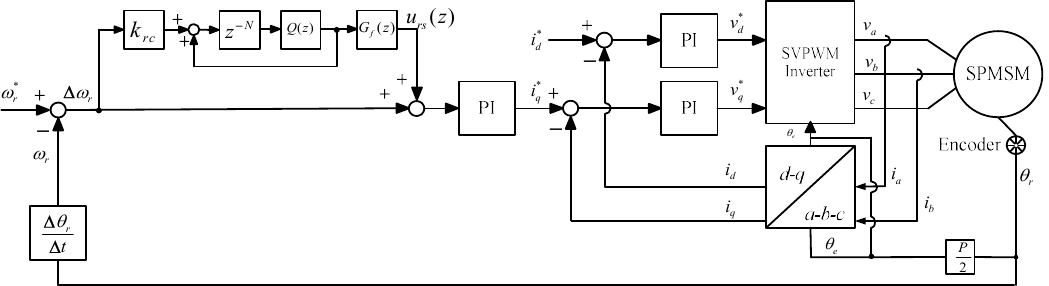
Figure 7. Detailed block diagram of speed-loop and current-loop PI controllers in an SPMSM drive system.